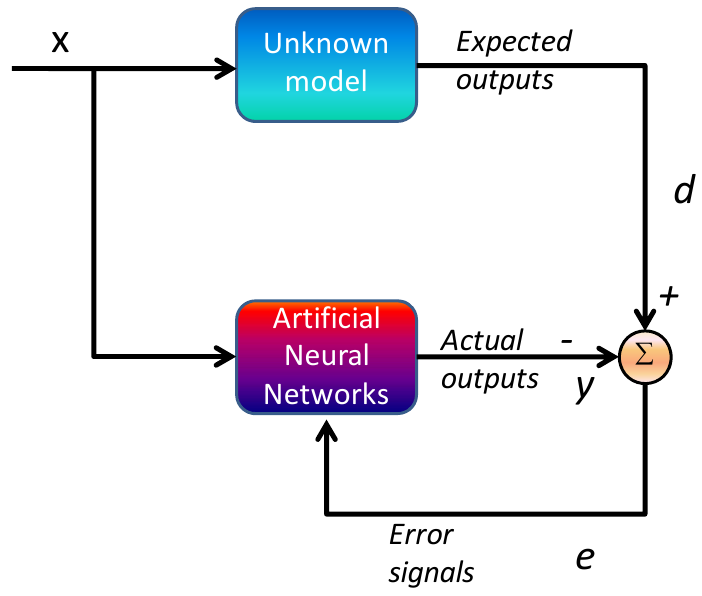
Figure 5. Supervised learning for function